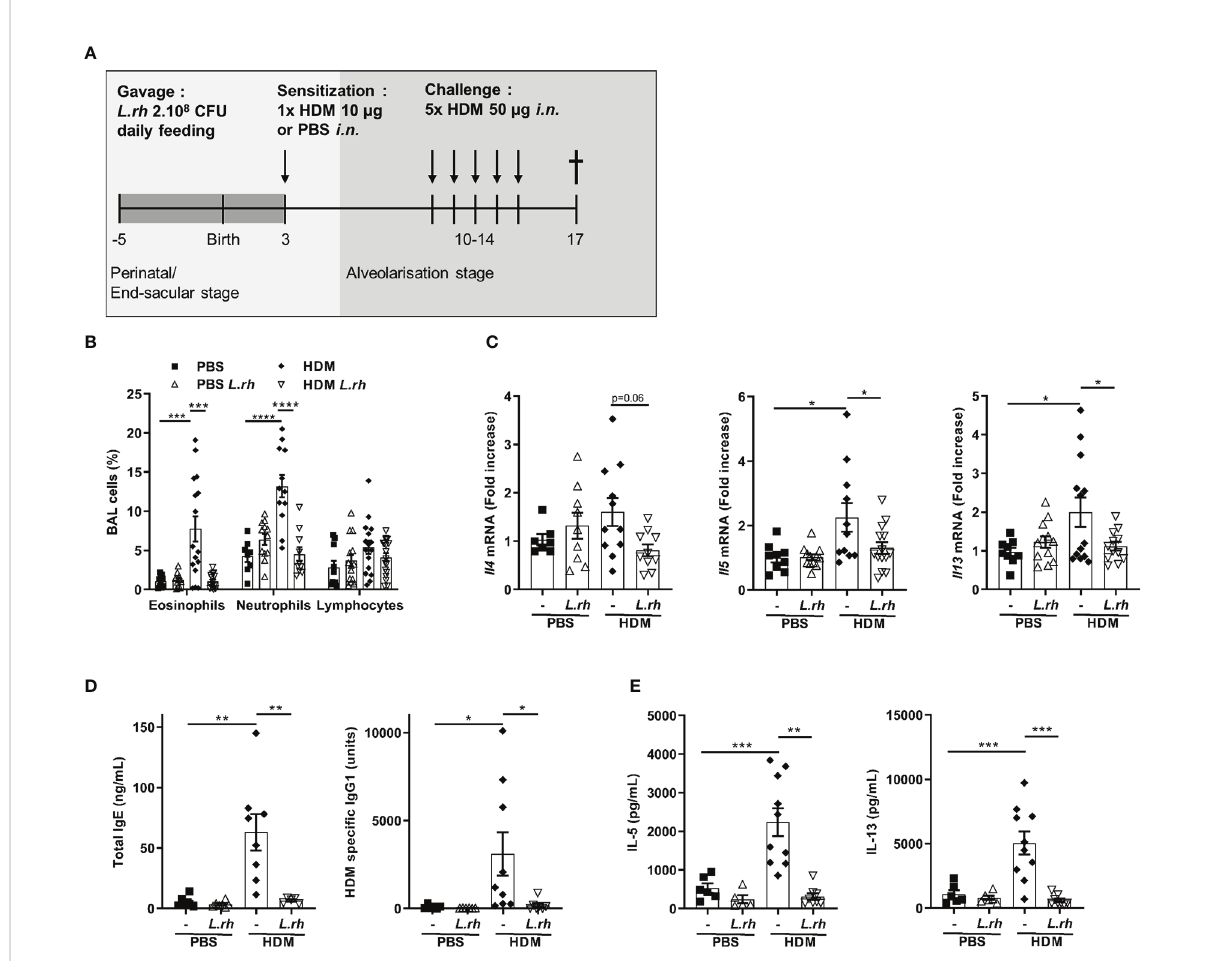
FIGURE 6 Perinatal L.rhamnosus exposures prevents neonates from type 2 responses to HDM. (A) Protocol of allergic asthma induction. Neonates born from C57BL/6 control (-) or probiotic-supplemented mother ( L.rh ) were mock-sensitized with PBS or sensitized with 10 µg HDM on PND3 and were challenged with 50 µg HDM on 5 consecutive days one week after sensitization. Mice were sacri fi ced on PND17. (B) Cell percentages in the BAL were determined 72h after the last challenge by FACS. (C) Pulmonary mRNA normalized expression of Il4 , Il5 and Il13 were analyzed by qRT-PCR. Relative units were obtained by comparing each group to the mean of non-treated PBS mice. (D) Total IgE and HDM-speci fi c IgG1 in serum were obtained by ELISA. (E) Th2-associated cytokines in MLN restimulated for 3 days with 15 µg/mL HDM were measured by ELISA. Results are a pool of 3 – 4 independent experiments and are shown as mean ± SEM. Statistical analysis was done using an ordinary one-way ANOVA (Holm-Sidak ’ s multiple comparisons test) or a Kruskal-Wallis test (Dunn ’ s multiple comparisons test) (* = p <0.05; ** = p <0.01; *** = p <0.001; **** = p